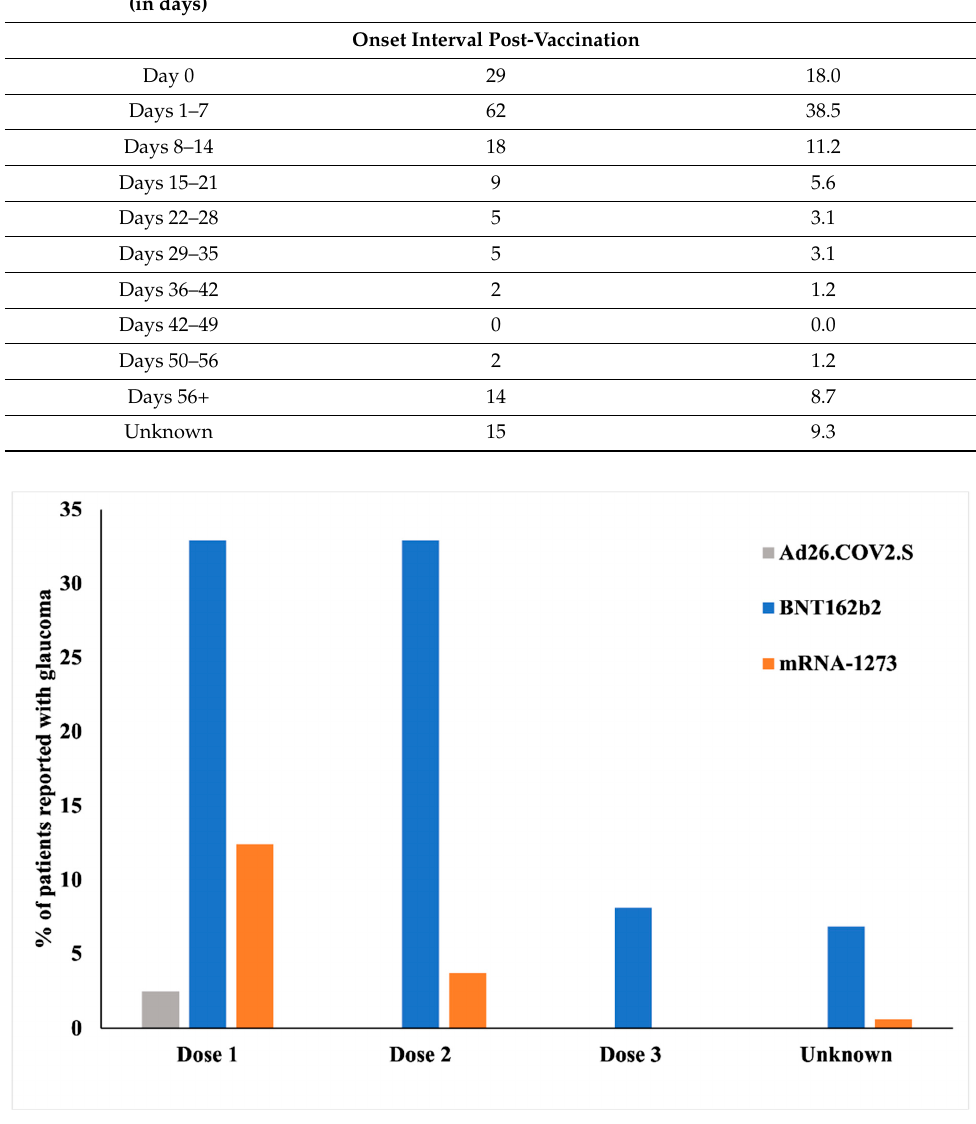
Figure 2. Cases of glaucoma post-vaccination with protocol doses (Doses 1 and 2 for BNT162b2 and mRNA-1273 and Dose 1 for Ad26.COV2.S) and boosters.